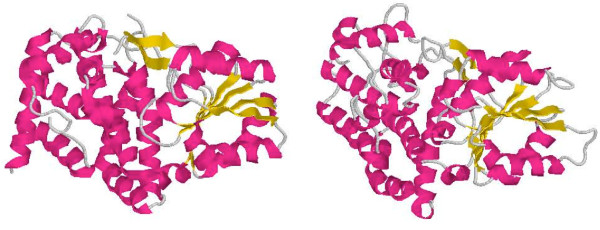
EVEREST family EV01.04463. Left: [PDB:1JQA], a representative protein structure of SCOP family "Iron-containing alcohol dehydrogenase". Right: [PDB:1DQS], a representative protein structure of SCOP family "Dehydroquinate synthase, DHQS". Both families belong to SCOP superfamily "Dehydroquinate synthase-like", which is fully reconstructed by [EVEREST:EV01.04463]. Notice how the two structures are distinct, yet similar. For details of this example see Super-family in section Examples: Selected EVEREST Families.